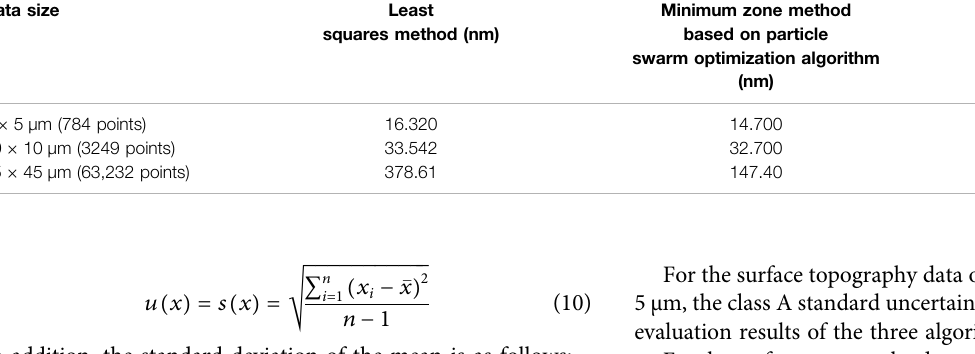
TABLE 2 | The average value of fl atness error evaluation results of three algorithms under different SHS sample surface area. Data size Least squares method